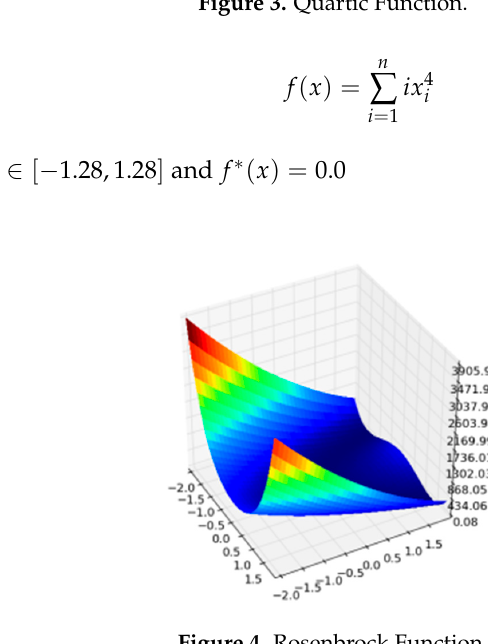
Figure 4. Rosenbrock Function.